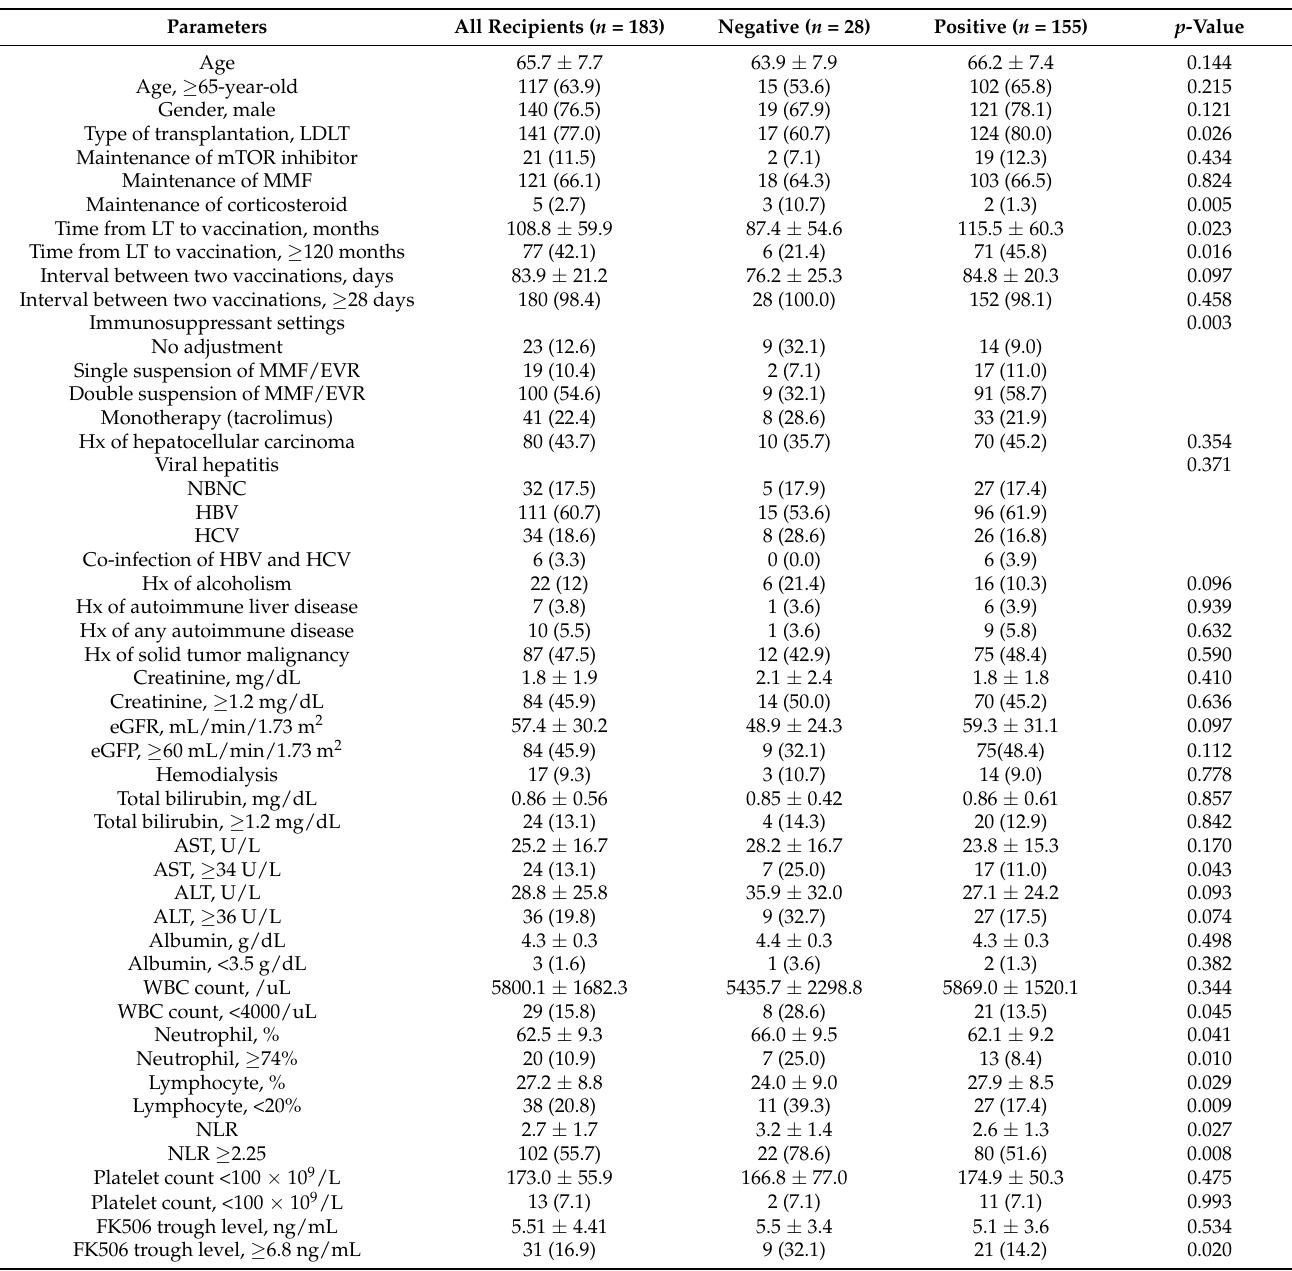
Table 1. Comparison of patients’ characteristics according to negative or positive humoral response to two-dose Moderna mRNA-1273